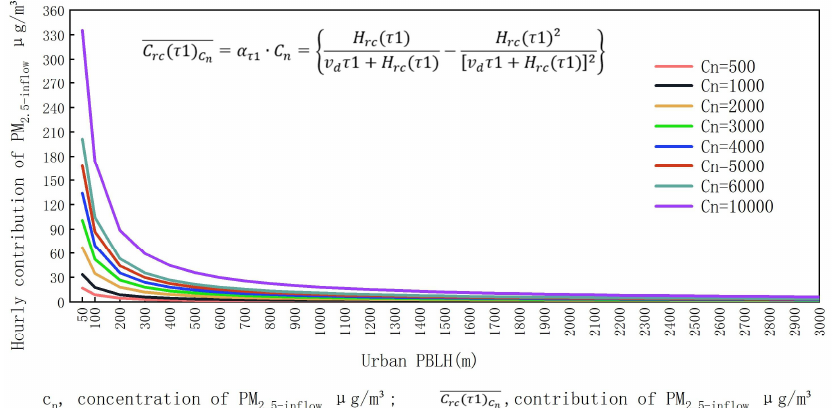
Figure 11. Relationship between the hourly contribution of PM 2.5-inflow and urban PBLH at different specific PM 2.5-inflow concentrations.